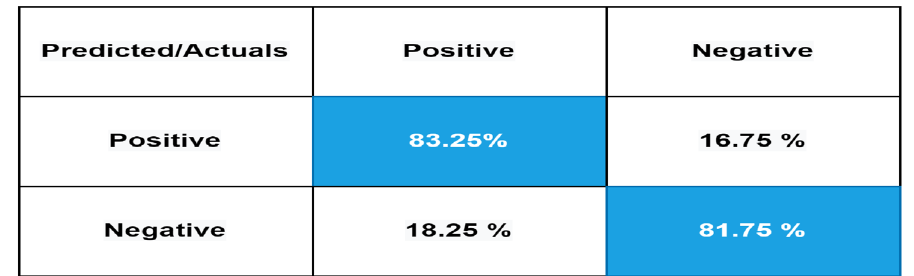
Figure 7. Confusion matrix of our proposed model using UCSA